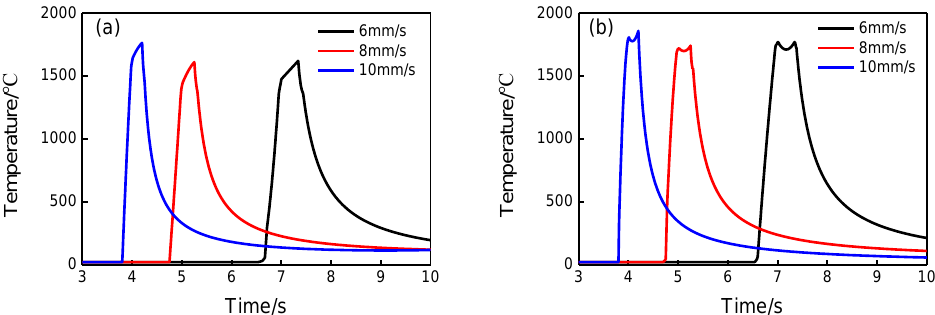
Figure 7. Thermal histories of points at: ( a ) deposit / substrate interface; ( b ) top surface of the deposits for the three scanning speeds obtained by finite element analysis.